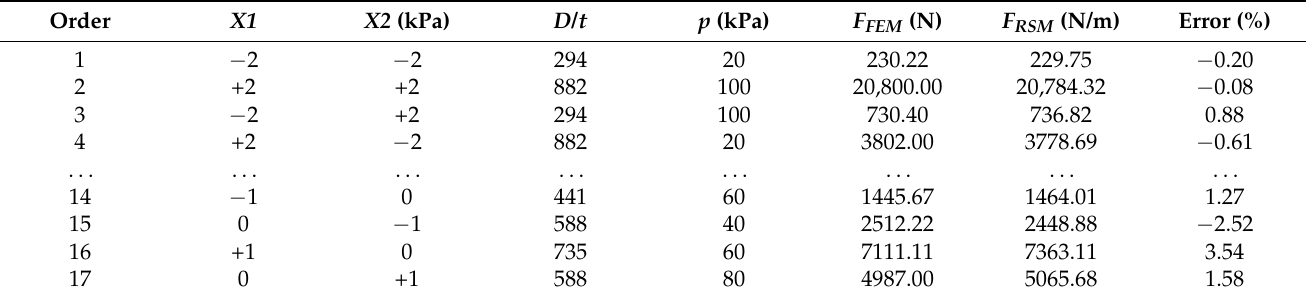
Table 4. Results of the ultimate load from RSM and FEM .